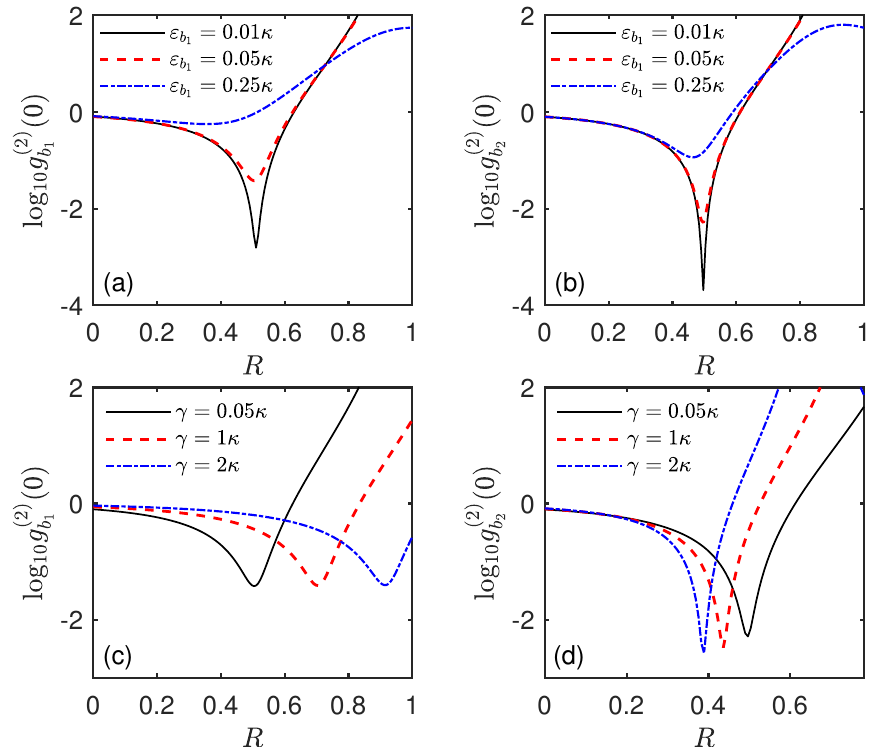
( 2 ) ( 0 ) of the SAW mode b 1 and b i / κ and ( c , d ) for 1 = 0.05 κ 1